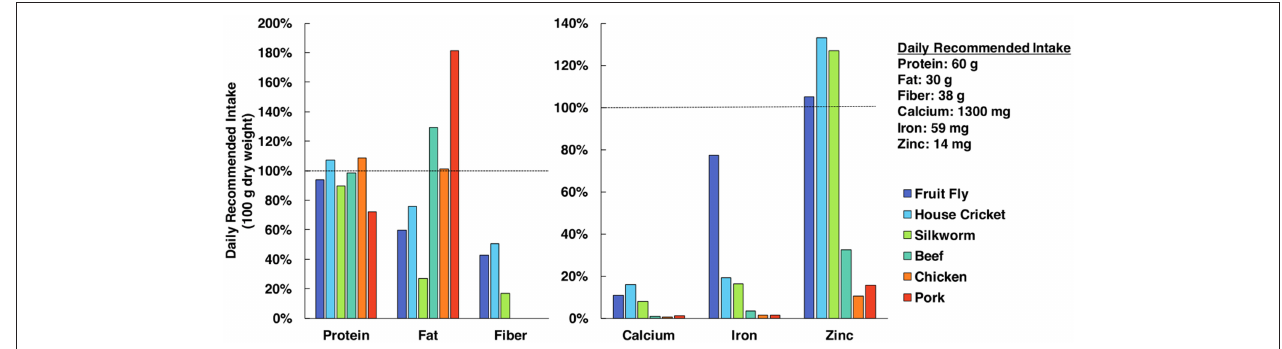
FIGURE 1 | Nutrient profile comparison of edible insects and popular mammalian meats (Rumpold and Schlüter, 2013; Nutrient Data Laboratory, 2018). Nutrients are quantified in terms of percent of daily recommended intake (DRI) in a 100g sample (dry basis). Protein, fat and fiber DRI values are specifically for men < 50 years old and weighing 75kg (Institute of Medicine, 2005) and mineral DRI values were selected as the greatest value from the respective ranges (Food Agriculture Organization/World Health Organization,